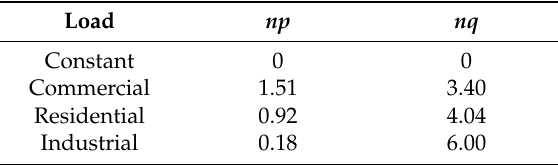
Table 1. Load models and exponents